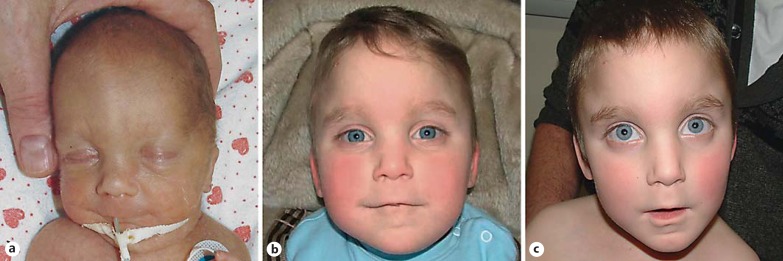
Frontal view of the facial characteristics. a Shortly after birth. b At age 3 years. c At age 6 years.